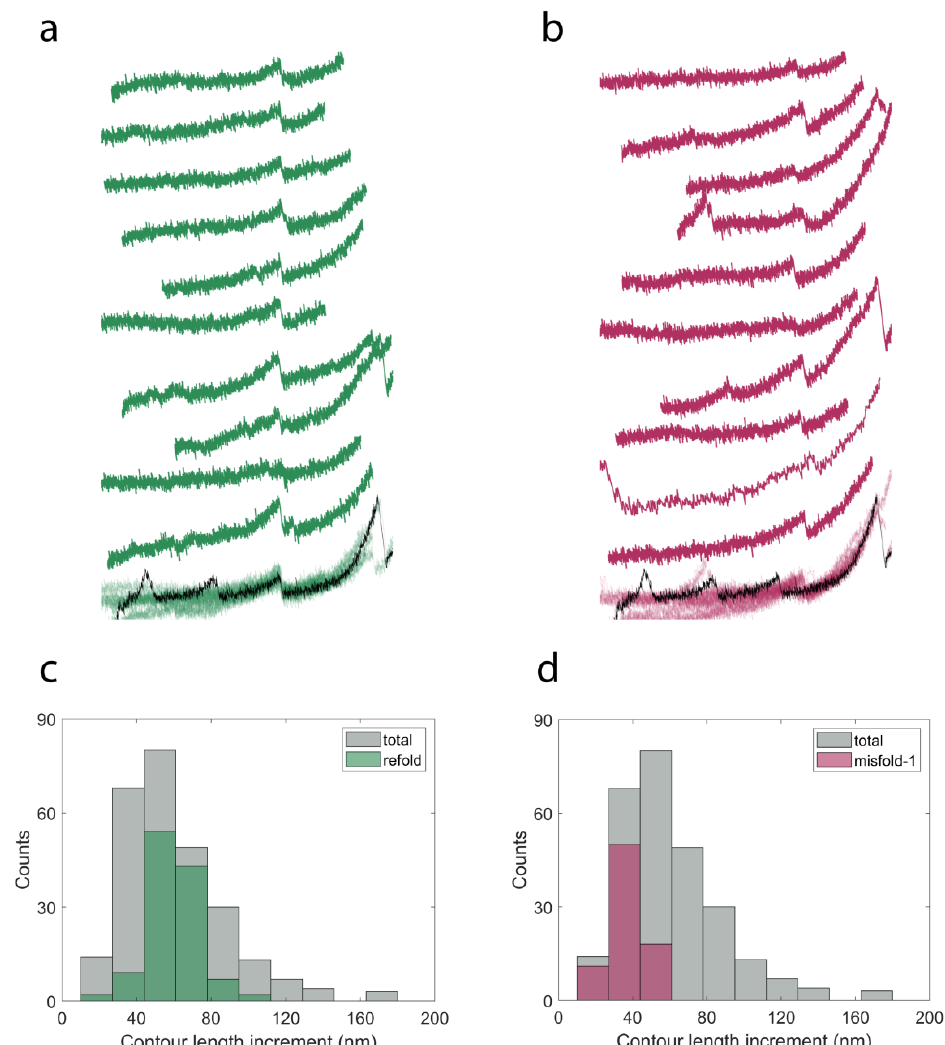
Figure 6. ( a ) Ten examples of curves of refolded proteins. ( b ) Ten examples of peaks with a smaller contour length increments from misfolded proteins. The template is plotted in a black line for ( a , b ). The corresponding distributions of contour length increments are shown in ( c , d ), respectively. Sturge’s formula was used to calculate the number of bins for ( c , d ). Bin size of the total recordings was used for the refold ( c ) and misfold-1 ( d ) results for